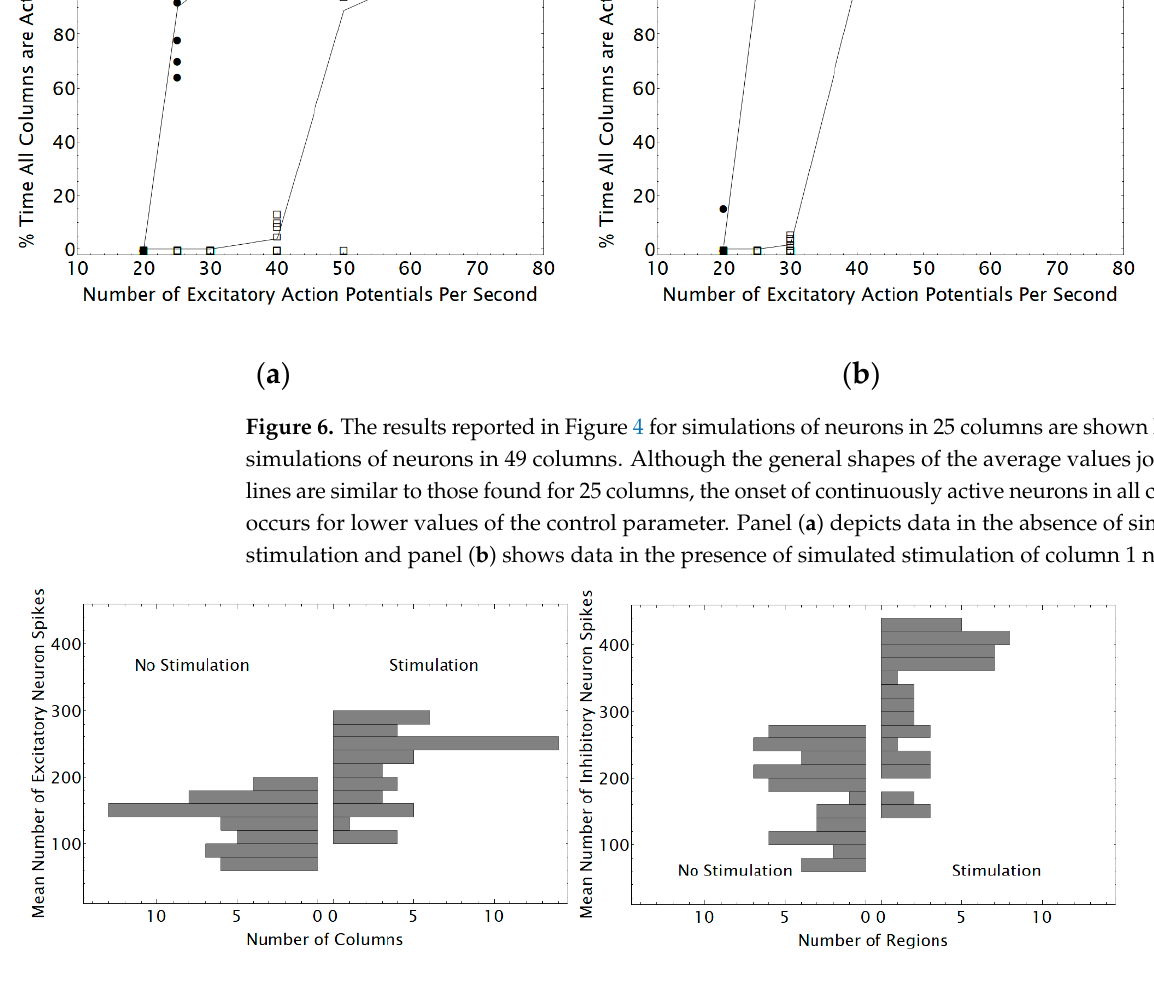
Figure 7. The distributions of numbers of spikes for network excitatory ( a ) and inhibitory ( b ) neu- rons in columns 1–49 averaged over 10 s simulations are shown for both no stimulation and stimu- lation conditions. The frequency of extrinsic excitatory action potentials was set to 70/s .